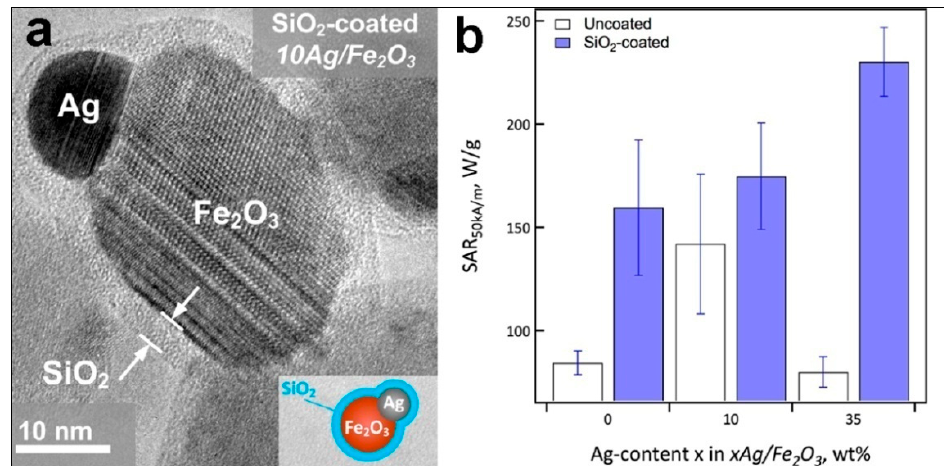
Figure 5. SiO 2 coated Fe 2 O 3 -Ag heterodimers. HRTEM image of heterodimer structure, with 10 wt% Ag ( a ) and specific absorption rate (SAR) values of uncoated and SiO 2 coated heterodimers with different Ag concentrations ( b ). Reproduced with permission from [17], copyright (2013) American Chemical Society.